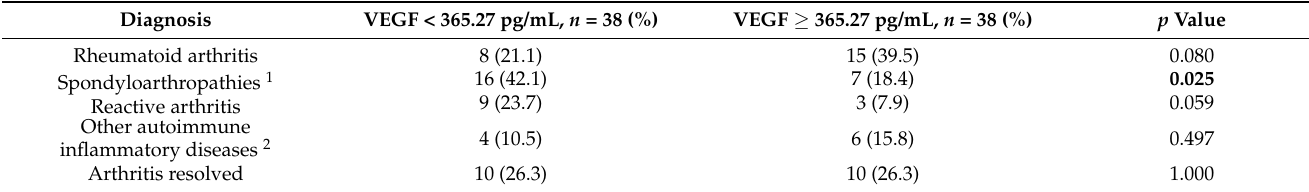
Table 10. Association between undifferentiated arthritis study cohort outcomes based on VEGF median levels in undifferentiated arthritis patient